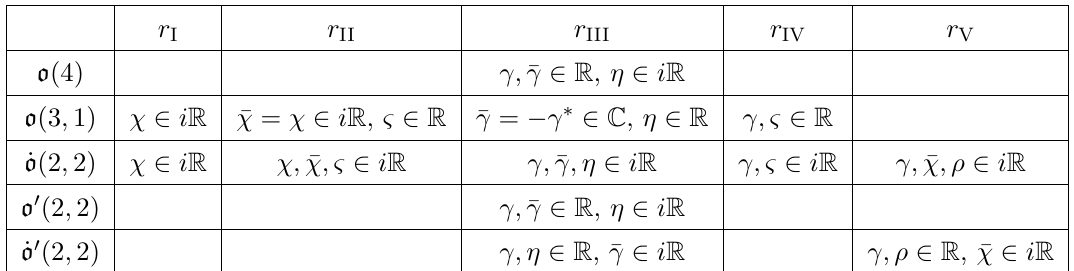
= (cid:15) M generate the o (3) algebra, correspond- i ijk jk